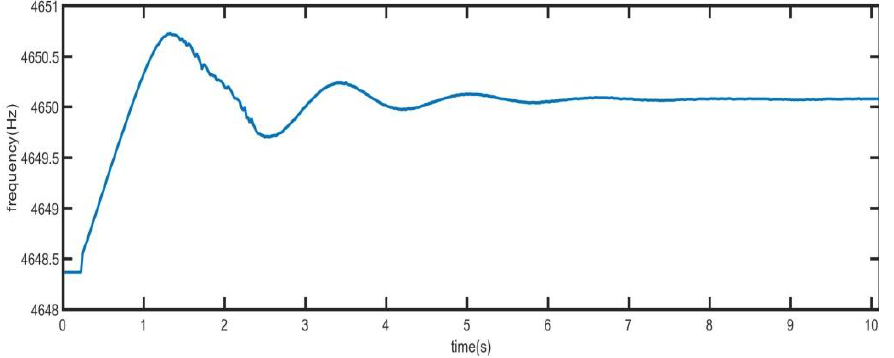
Figure 15. Vibration frequency of driving mode.